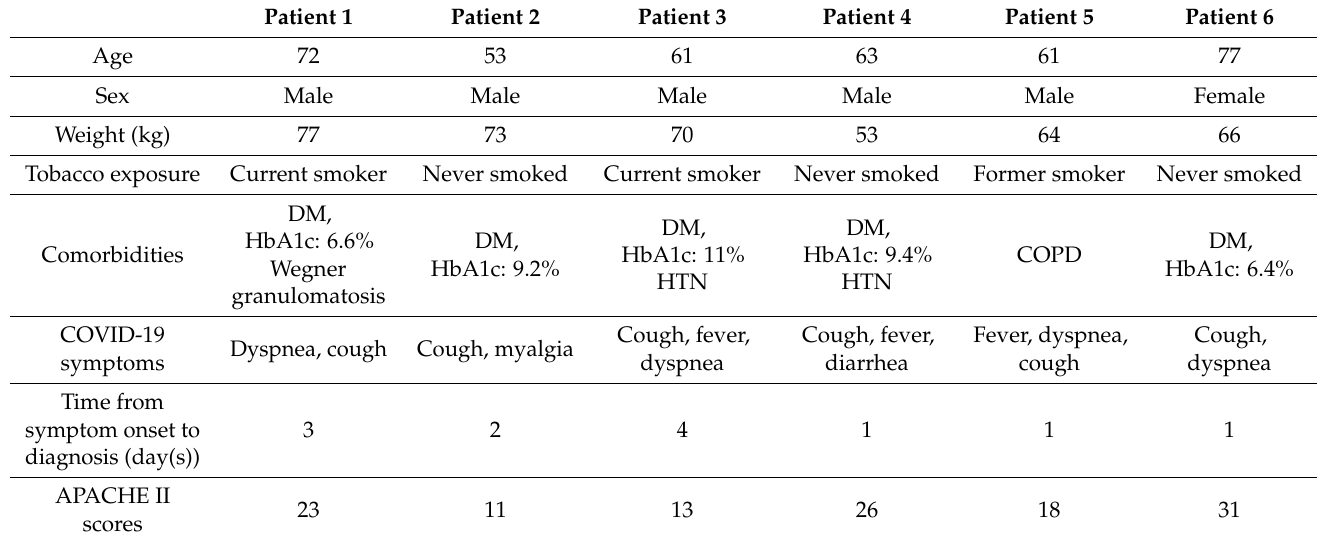
Table 1. Clinical characteristics and initial presentations of six patients with COVID-19 complicated by invasive aspergillosis who received